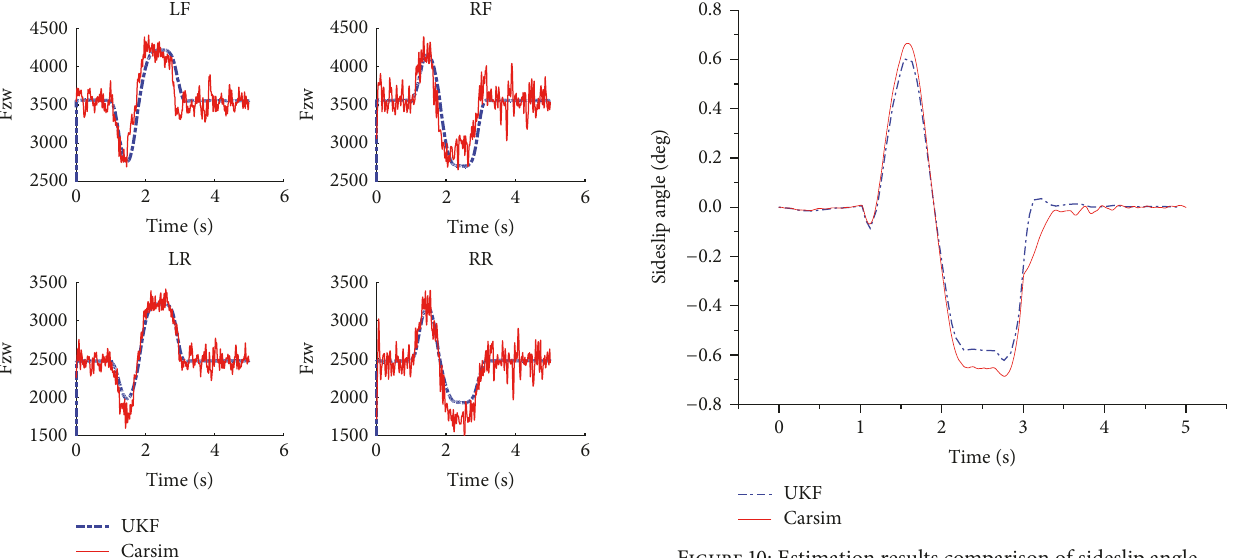
Figure 8: Estimation results comparison of vertical forces.